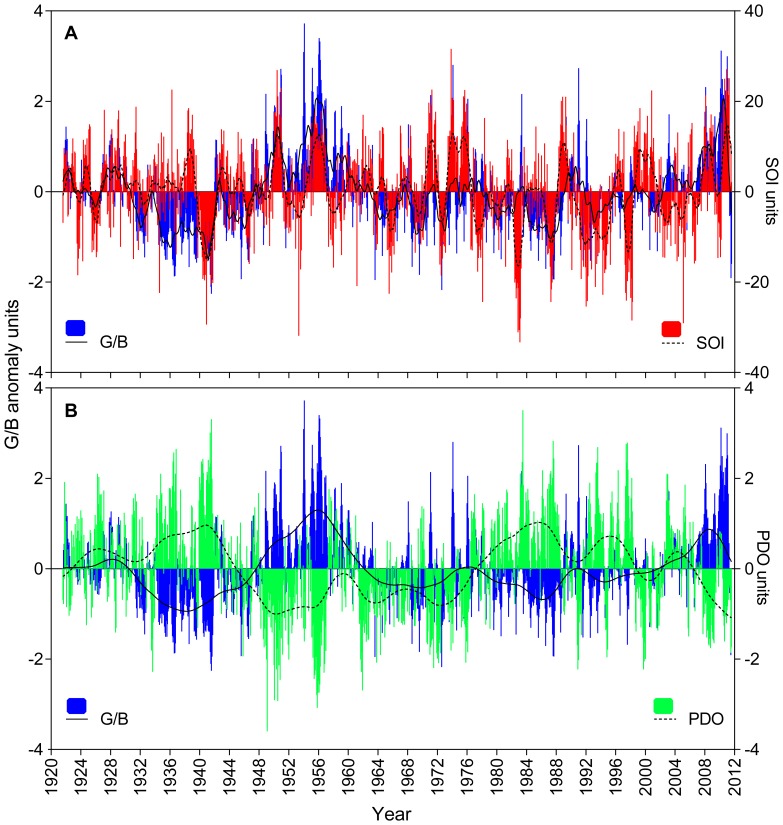
Relationship between monthly values of G/B anomalies and climatic oscillations for the period 1921–2011.(A) Southern Oscillation Index (SOI) and (B) Pacific Decadal Oscillation (PDO). Solid and dashed lines are 12-month and 85-month moving averages respectively. Data at annual resolution is provided in supplementary information (Figure S3).